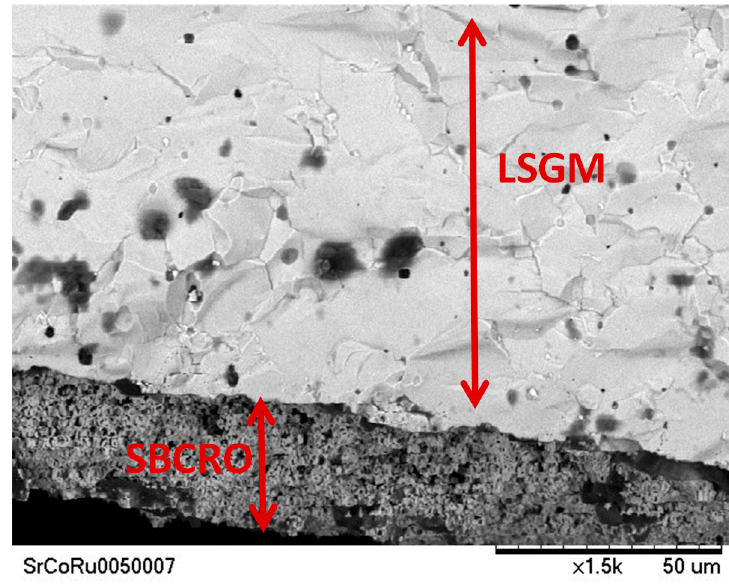
Figure 10. SEM micrograph showing the porous cathode layer of Sr 0.9 Ba 0.1 Co 0.90 Ru 0.10 O 3 − δ tightly